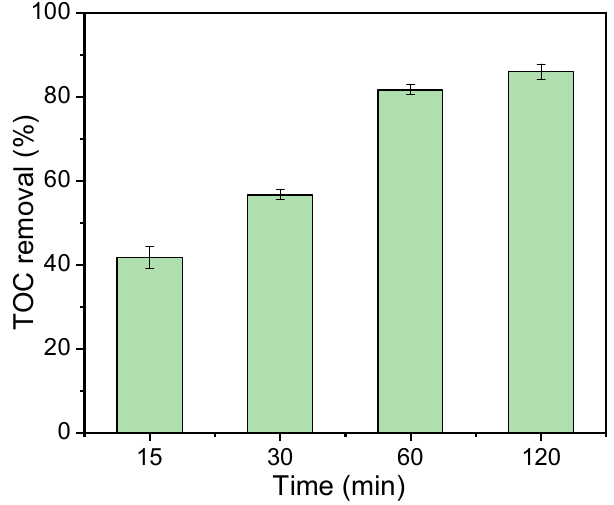
Figure 10. TOC removal for phenol mineralization by BC-24/PDS system.